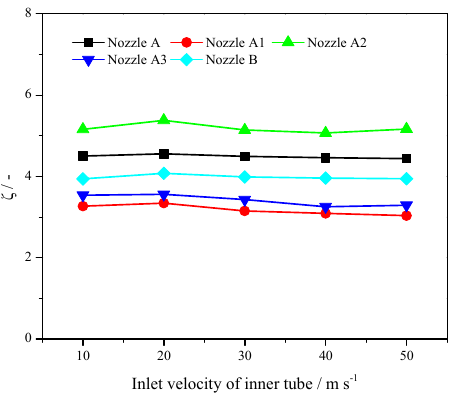
Figure 6. Resistance coefficients of air nozzles.